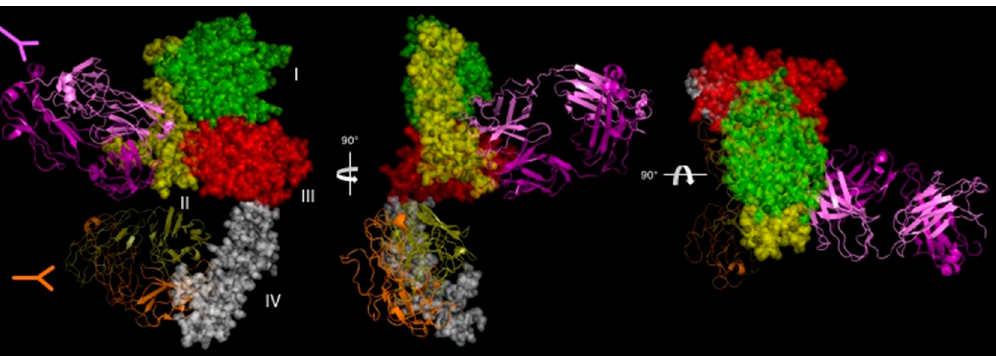
Figure 4. HER2 extracellular segment bound by the Fab of pertuzumab (purple/violet) and trastuzumab (orange/deep olive). HER2 domains I, II, III, and IV shown in green, yellow, red, and white, respectively. Full antibodies for pertuzumab and trastuzumab depicted by Y figures in violet and orange, respectively. Figure adapted from crystal structure 6OGE [111].